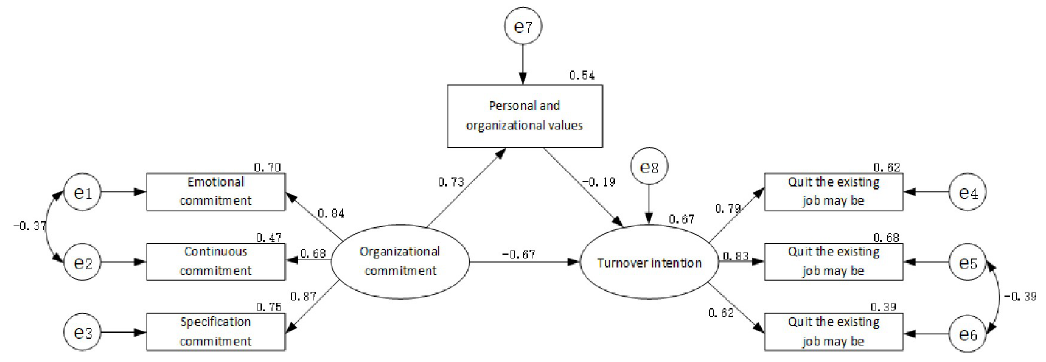
Fig 2. Structural equation modeling results.